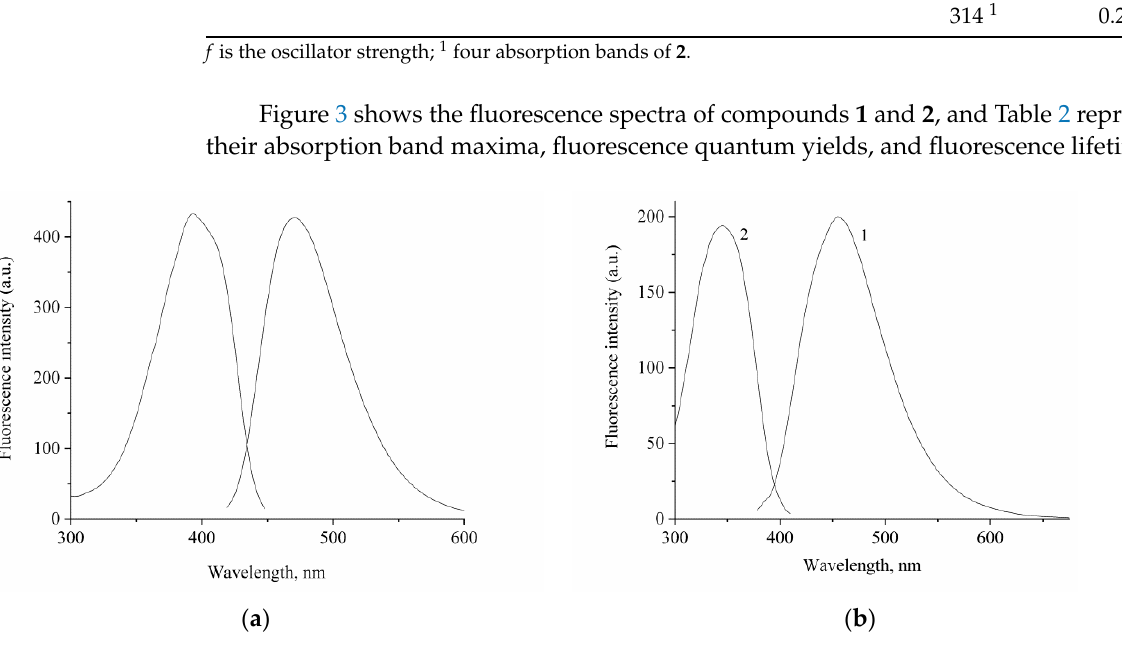
Figure 3. Fluorescence emission (1) and excitation (2) spectra of compounds ( a ) 1 and ( b ) 2 . The concentration of compounds 1 and 2 is 5 × 10 − 6 mol/L. Table 2. Emission band maxima, fluorescence quantum yields φ and fluorescence lifetimes.